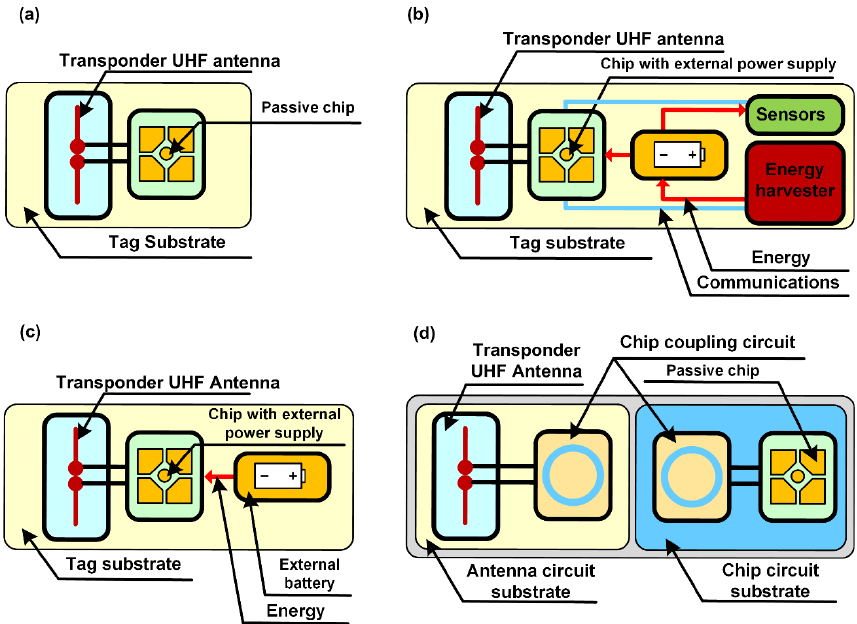
Figure 2. Simplified block diagrams of different types of RFID UHF transponder: ( a ) passive transponder; ( b ) semi-passive transponder equipped with an energy harvesting system and an autonomous set of sensors; ( c ) simple semi ‐ passive transponder equipped with battery; and ( d ) RFIDtex textronic transponder with separated chip and antenna.